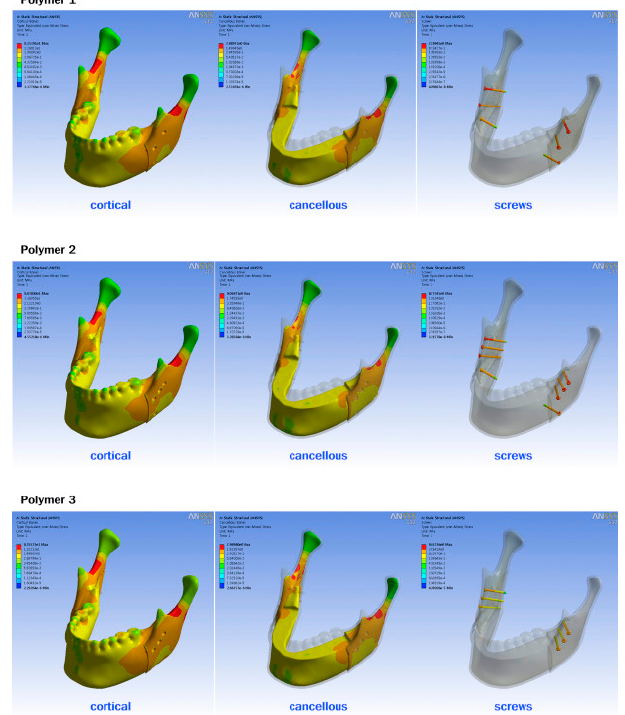
Figure 4. The distribution of stress in polymer screws according to different screw configurations: 1—triangular, 2—reinforced triangular, 3—linear. Reproduced with permission from [75], Elsevier, 2017.